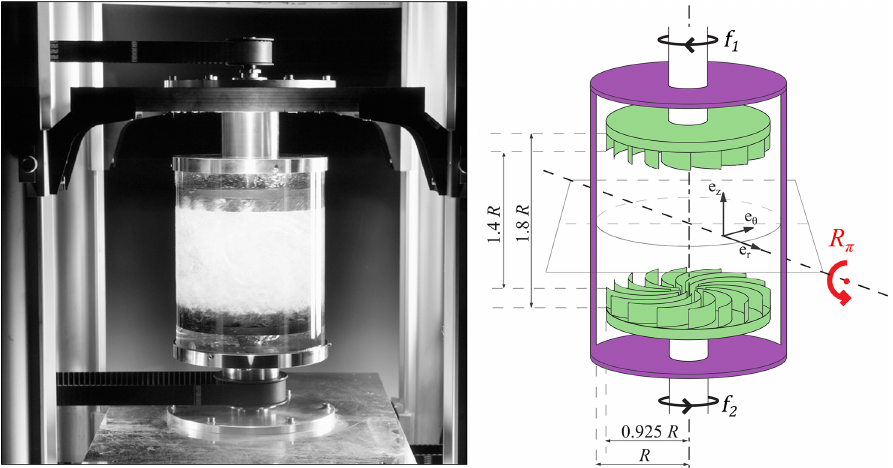
Figure 2. Picture and diagram of the experimental set-up. The black arrows indicate the direction of turbine rotation. Symmetry: the system is symmetric by any rotation R π – an angle π (shown by the red arrow) around any axis located in the equatorial plane and passing through the axis of rotation – it is the symmetry of an hourglass that is reversed. Positive vertical angular momentum is injected at the bottom, and negative vertical angular momentum is injected at the top via the impellers. The resulting imbalance induces a large-scale circulation, from the top and bottom to the middle plane, in analogy with the large-scale oceanic or atmospheric circulations from the Equator to the poles (picture courtesy of Pierre Cortet). Table 1. Analogy between the Earth system fluid envelopes and the von Kármán turbulent swirling flow stirred by impellers (Fig. 2). Natural flows von Kármán flow Geometry Spherical Cylindrical Solar